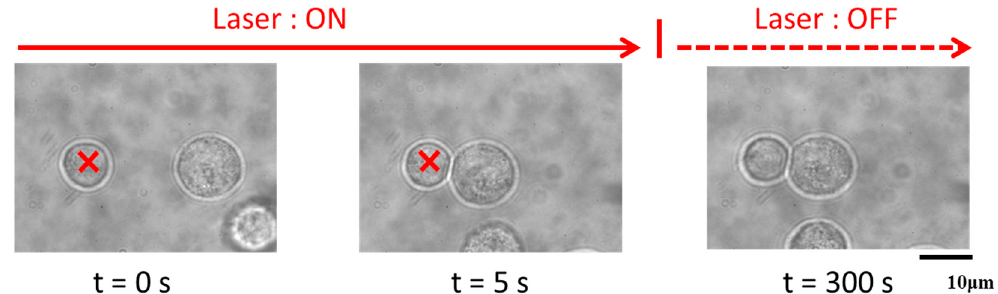
Figure 5. Stable cellular assembly of Neuro2A cells in a dextran (50 mg/mL) medium using optical laser tweezers. The focal point of the laser is marked by the red ‘x’.